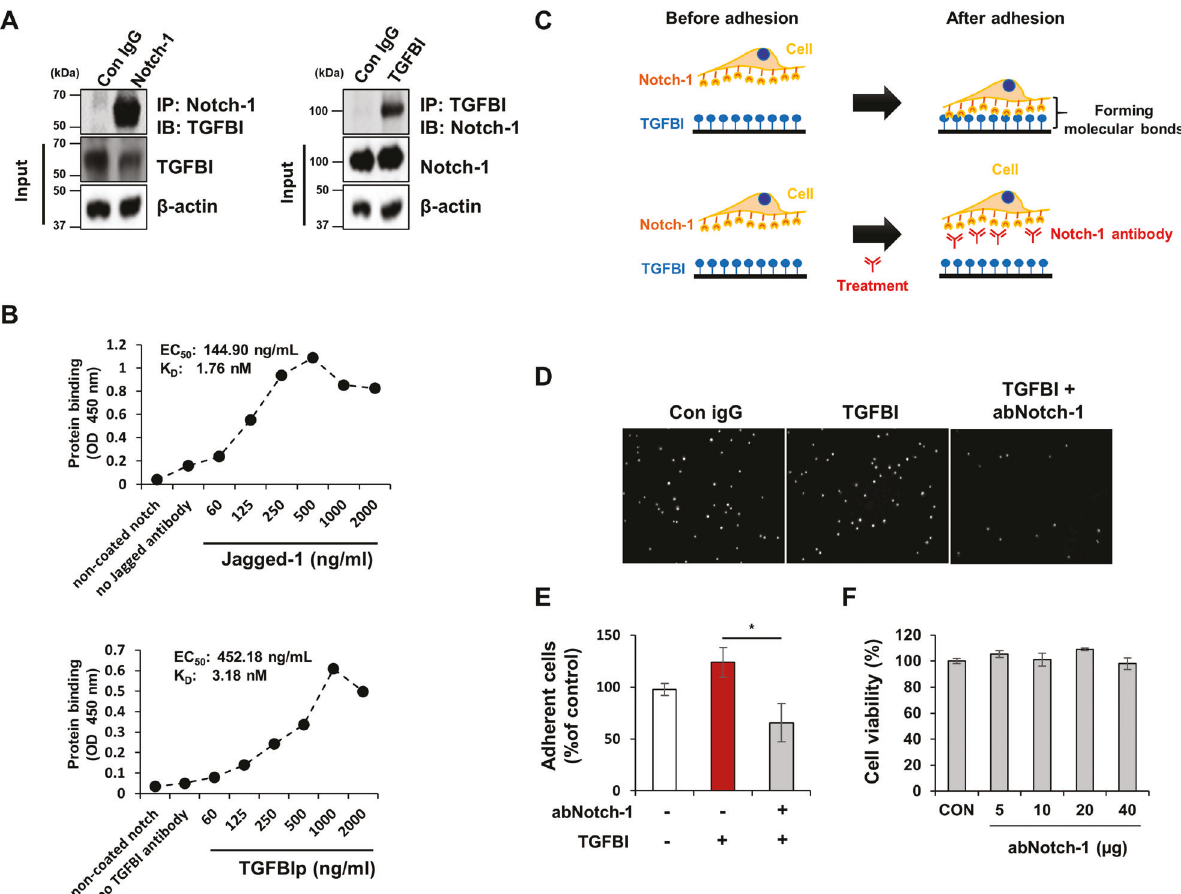
experimental design for the cell adhesion assay. D-E Pretreatment of 3T3-L1 adipocytes with either control IgG or Notch-1-speci fi c antibody (abNotch-1) was performed, and the cells were allowed to adhere to recombinant TGFBI-coated plates. F Cytotoxicity of abNotch-1 at the indicated concentrations was tested using an MTT assay. Error bars represent the ± SEM. * p < 0.05 by two-sided t